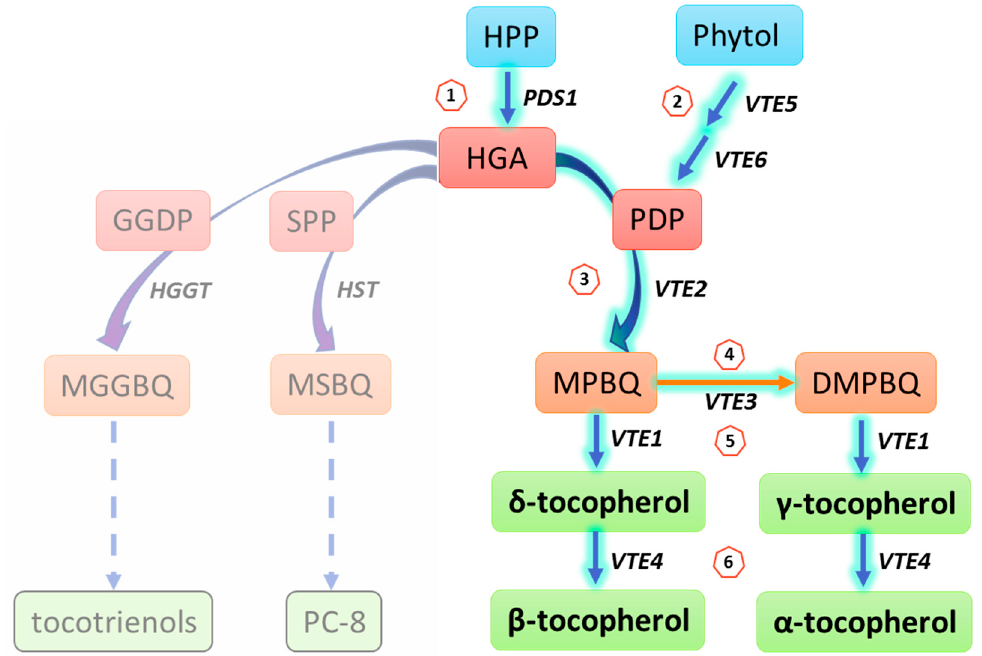
Figure 1. Simplified model of the tocopherol biosynthesis pathway in A. thaliana (highlighted branch of the pathway). Compound names are given in the boxes and gene names are indicated in italic. The circled numbers refer to the biosynthesis steps described in detail in Table 1. Adapted from [15]. HGGT : homogentisic acid geranylgeranyl transferase; HST : homogentisic acid solanesyl transferase; GGDP: geranylgeranyl diphosphate; MGGBQ: 2-methyl-6-geranylgeranyl-1,4-benzoquinol; PC-8: plastochromanol-8; SPP: solanesyl pyrophosphate